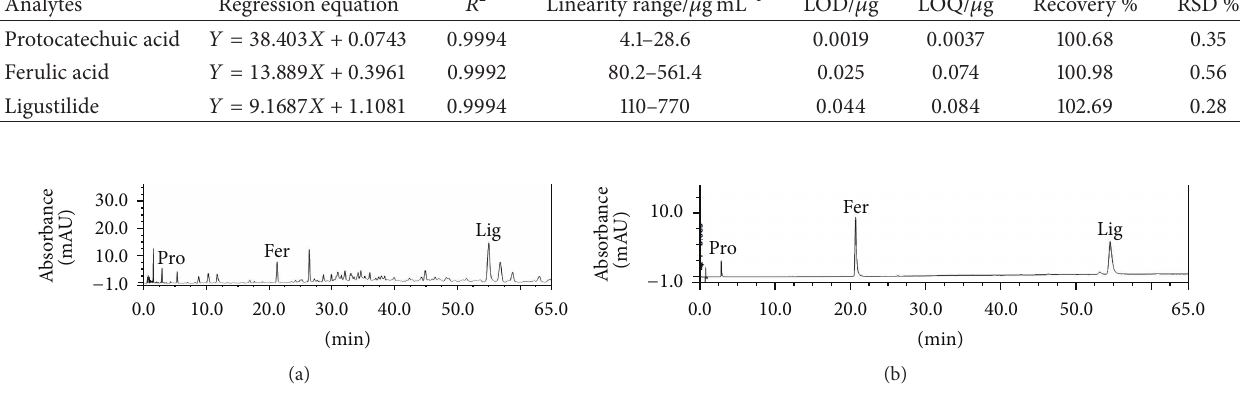
Table 1: Regression equations, correlation coefficients, linearity ranges, LODs, LOQs, and recoveries of investigated compounds. Analytes